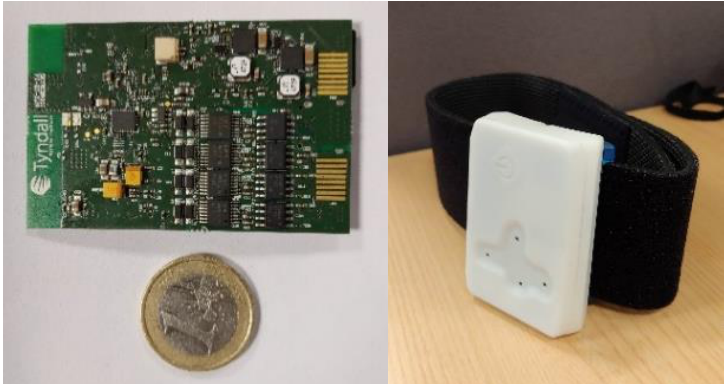
Figure 4. System block diagram. PCB board ( left ). The 3D printed enclosure with a Velcro strap ( right ).